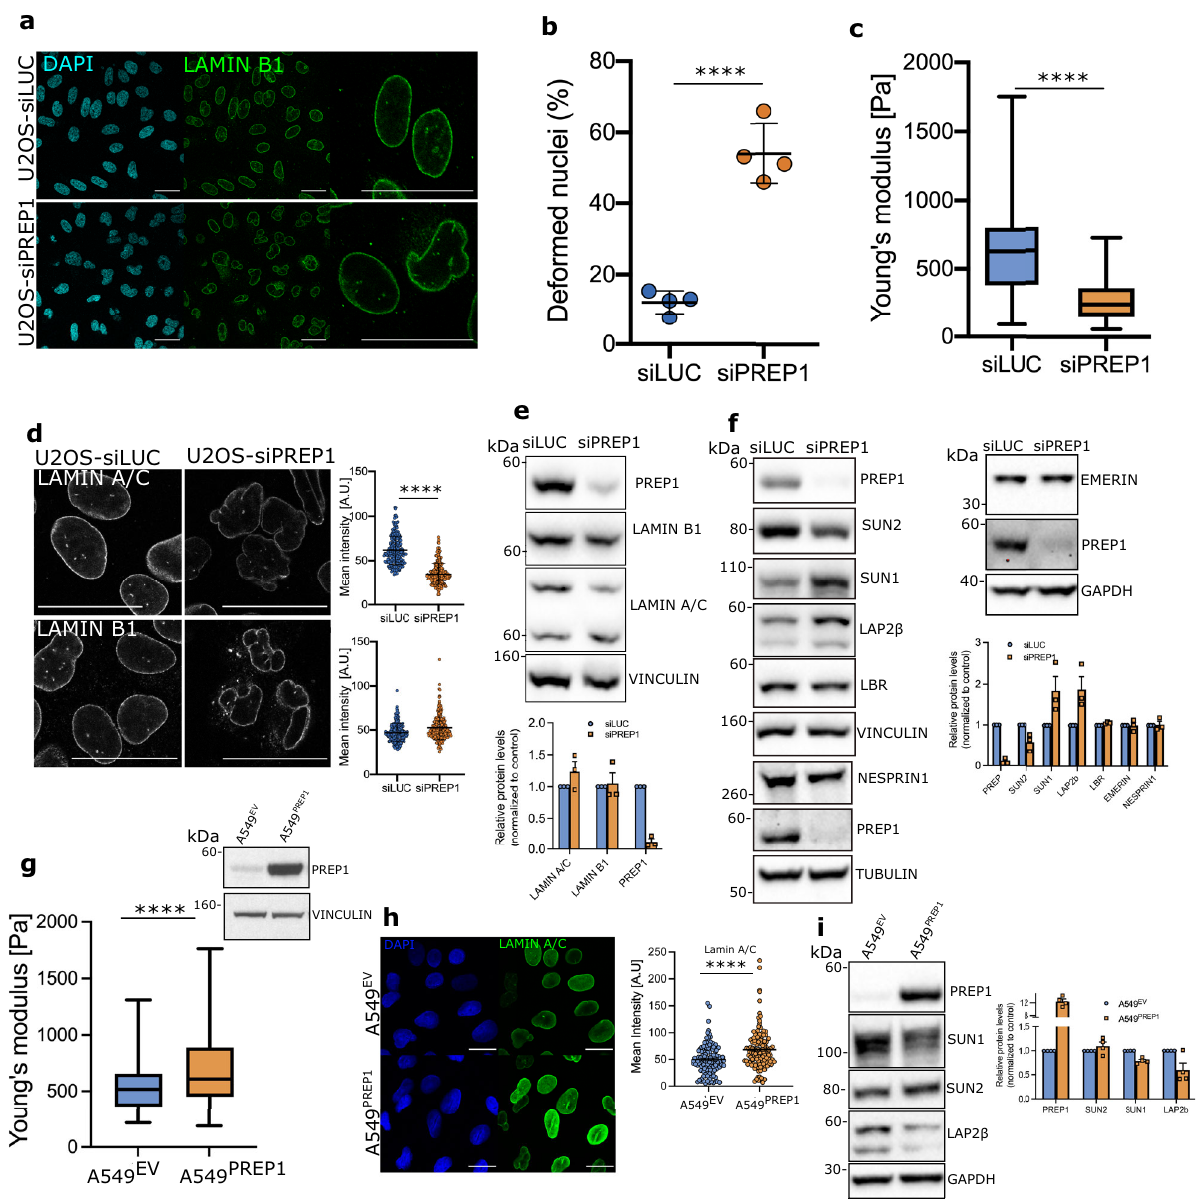
Fig. 1 PREP1 regulates nuclear envelope composition and nuclear rigidity. a Confocal images of control (siLUC) and PREP1 depleted (siPREP1) U2OS cells. DAPI staining (blue) detects the nucleus while LAMIN B1 staining (green) detects the nuclear lamina. Right panel shows nuclei at higher magni fi cation in siLUC and siPREP1 cells. Representative images of >3 independent experiments are shown. Scale bar is 40 µ m. b Scatter dot plot showing percent nuclear deformation in control (siLUC) and PREP1 depleted (siPREP1) U2OS cells in four independent experiments. N = 600 for siLUC and 884 for siPREP1. Error bars denote mean ± SD of four independent experiments. p < 0.0001. c Box plot showing Youngs ’ modulus measured by AFM in control (siLUC) and PREP1 depleted (siPREP1) U2OS cells. N = 40 cells. p < 0.0001. d Immuno fl uorescence images of control (siLUC) and PREP1 depleted (siPREP1) cells showing LAMIN A/C (upper panel) and LAMIN B1 (lower panel). Scale bar is 40 µ m. Corresponding scatter plots show quanti fi cation of fl uorescence intensity of LAMIN A/C (upper panel) and LAMIN B1 (lower panel). N = 232 (siLUC) and 244 (siPREP1) for LAMIN B1 analysis and N = 243 (siLUC) and 266 (siPREP1) for LAMIN A/C analysis. e Representative immunoblots of control (siLUC) and PREP1 depleted (siPREP1) U2OS cells showing LAMIN A/C and LAMIN B1 protein levels. Data is representative of three independent experiments. Bar graph shows densitometric analysis of LAMIN A/C and LAMIN B1 protein in three independent experiments. f Representative immunoblots of control (siLUC) and PREP1 depleted (siPREP1) U2OS cells showing various nuclear envelope proteins. Bar graph shows densitometric analysis of the proteins from three or more independent experiments. g Box plot showing Youngs ’ modulus measured by AFM in empty vector (A549 EV ) and PREP1 overexpressing (A549 PREP1 ) A549 cells. N = 40 cells. Inset immunoblot shows the PREP1 protein in A549 EV and A549 PREP1 cells. h Immuno fl uorescence images showing LAMIN A/C localization in A549 cells expressing empty vector (A549 EV ) or PREP1 (A549 PREP1 ). Scale bar is 20 μ m. Scatter plot shows mean fl uorescence intensity of LAMIN A/C of A549 EV or A549 EV and A549 PREP1 cells. Bar graph shows densitometric analysis of the protein intensity from three independent experiments. Error bars denote mean ±